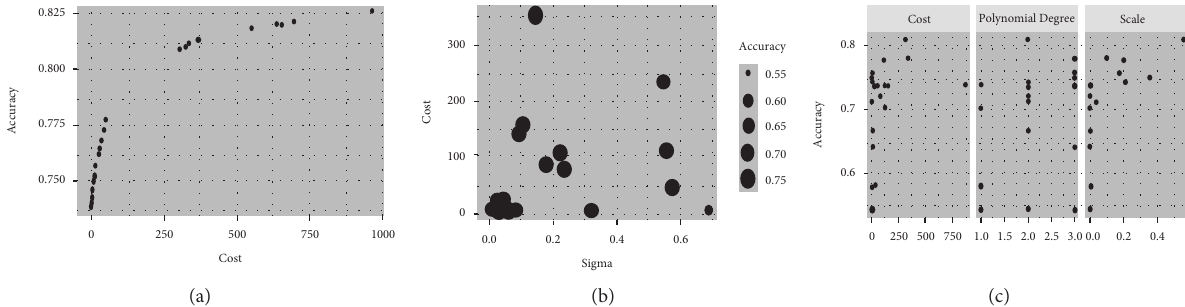
Figure 3: Optimized parameter selection using the grid search technique for KSE-100 index with (a) linear kernel, (b) RBF kernel, and (c) polynomial